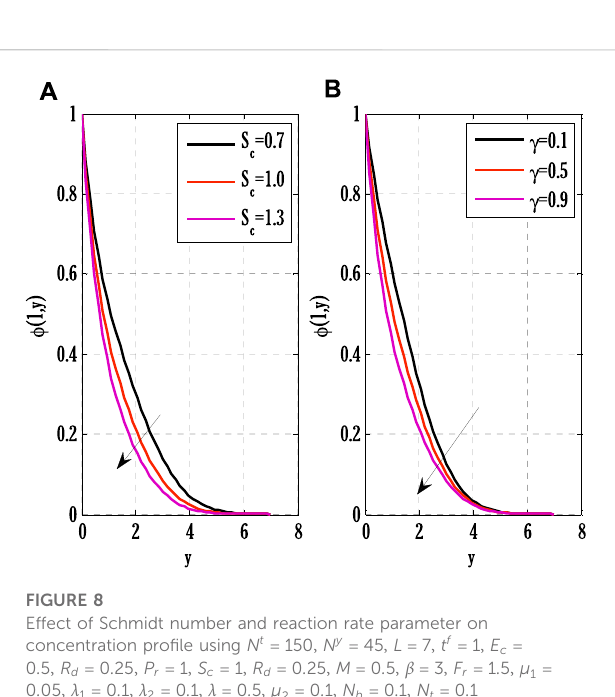
fourth-order in space, whereas Crank-Nicolson provides second-order accuracy in time and fourth-order in space, it converges faster than the existing scheme. Figs. 3 – 9 shows the effect of different parameters on velocity, temperature, and concentration pro fi les obtained by applying the proposed numerical scheme on Eqs. 61 – 64. Figure 3 shows the effect of the Casson parameter and magnetic parameter onthe velocity pro fi le. Itisseenthatthe velocity pro fi ledeclines by incrementing Casson and magnetic parameters. This fall in velocity